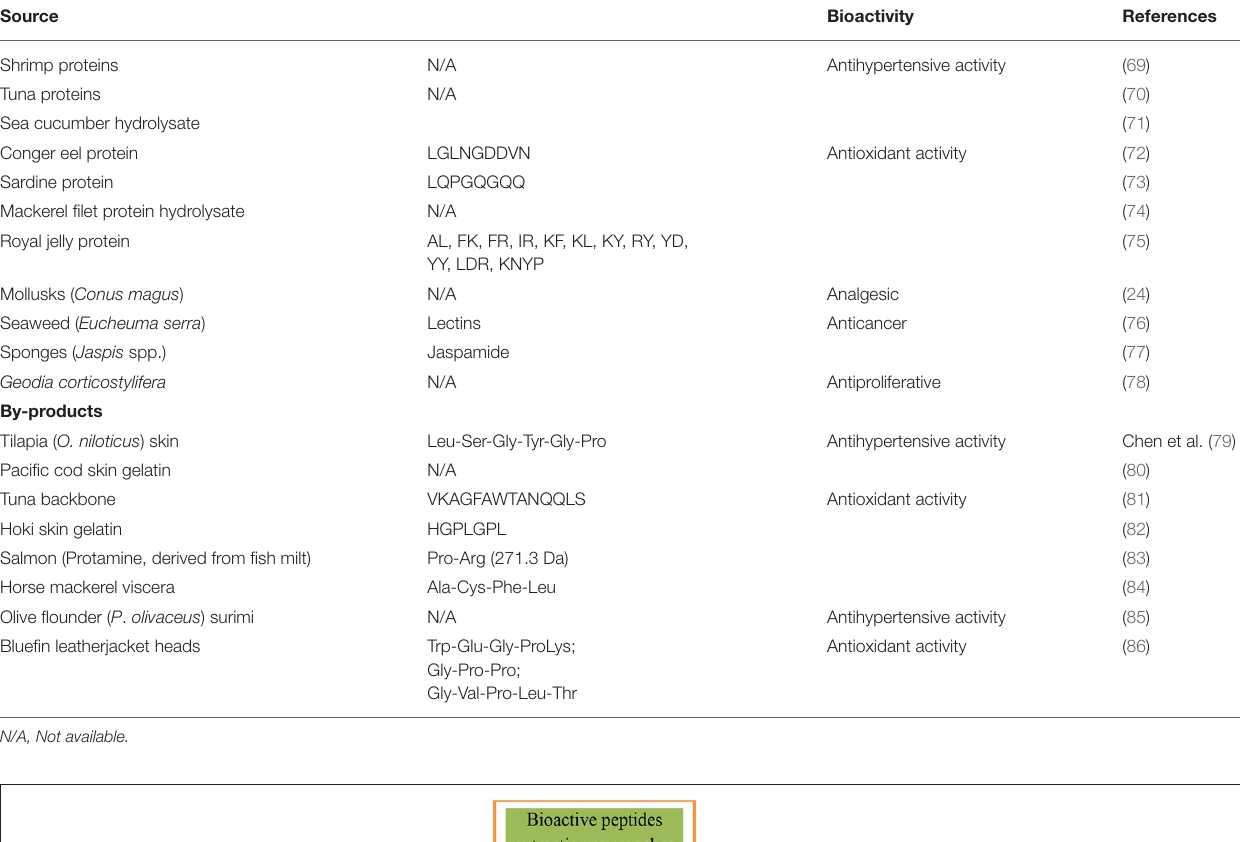
TABLE 4 | Peptides from marine and by-products and their bioactivity.